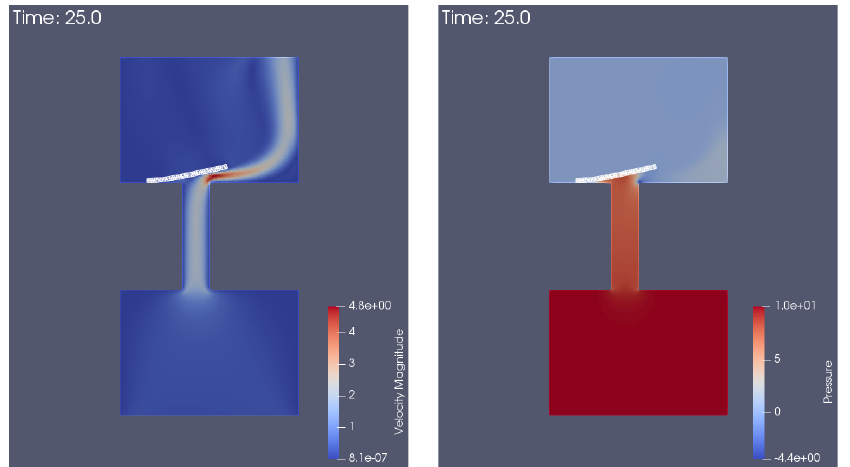
Figure 13. Velocity magnitude ( left ) and pressure ( right ) of the fluid at t = 25 ms, when the structure is at the highest